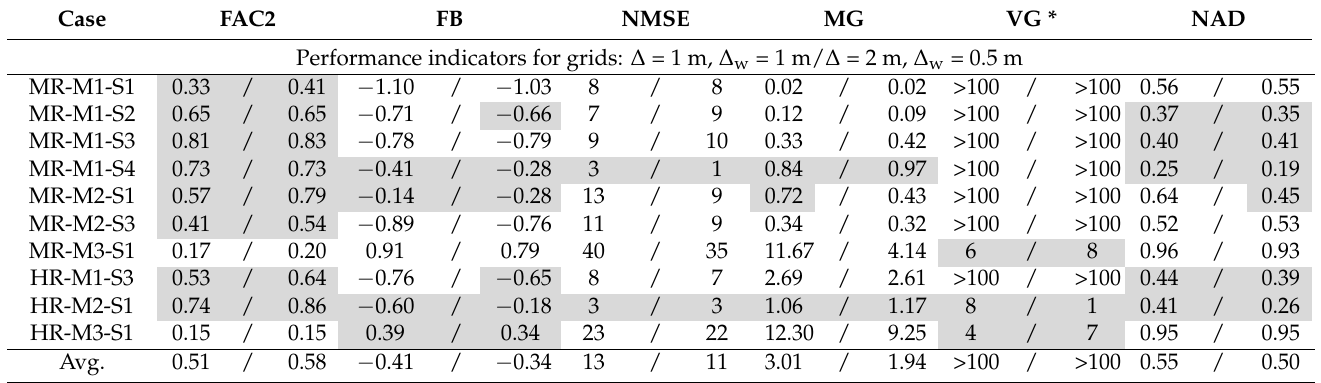
Table 5. Quantitative performance indicators for neutrally buoyant gas releases for all investigated cases for two different meshes ( ∆ = mesh size, ∆ w = refined mesh size at walls). In grey: performance indicators which met the